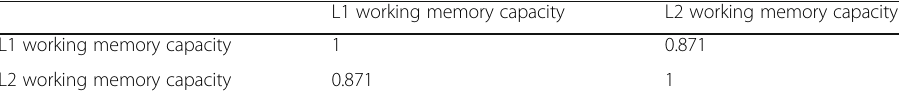
Table 7 Correlation between working memory and listening